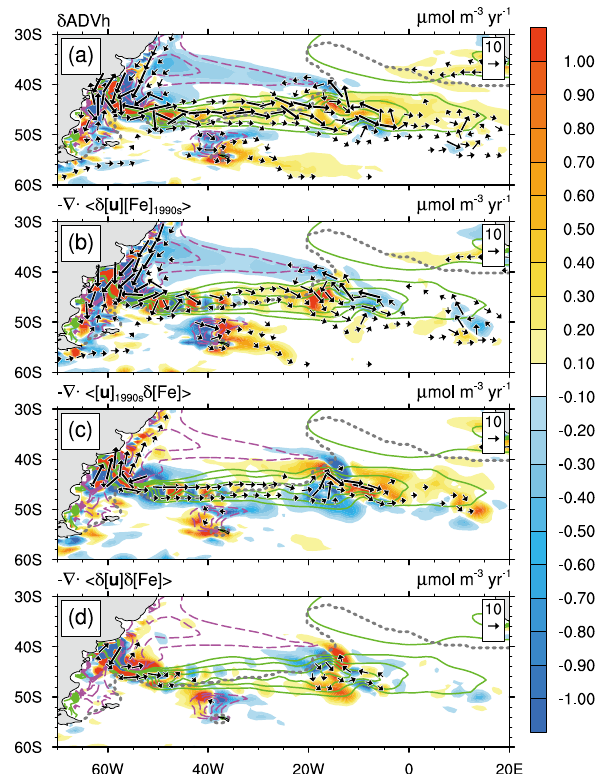
Fig. 15. The same as Fig. 12, but for the Brazil–Malvinas confluence zone. The maximum vector length is set to 20µmolm − 3 yr − 1 , and advection vectors with magnitudes of less than 2µmolm − 3 yr − 1 are omitted. Contour lines are the same as in Fig. 14b, but the zero contour is omitted. The gray dotted line represents the border of the simulated HNLC region in the